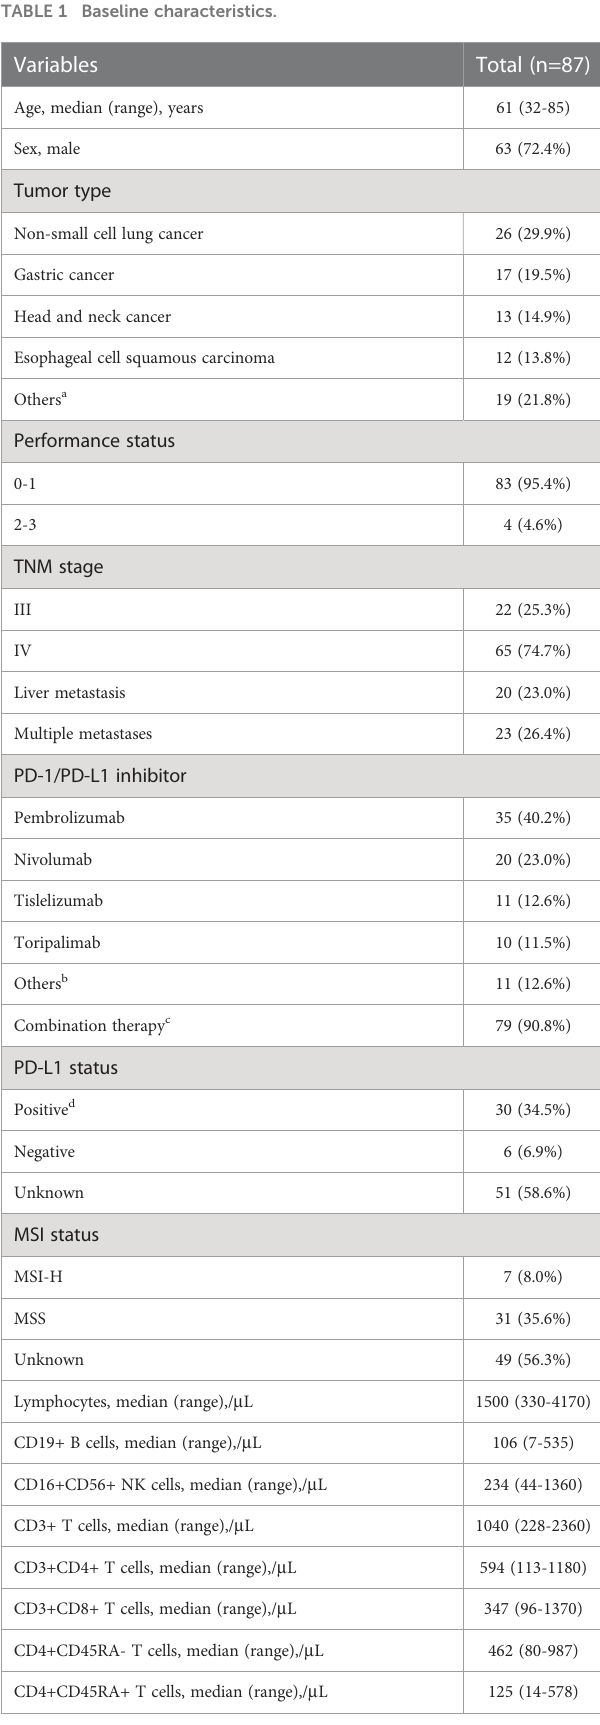
TABLE 1 Baseline